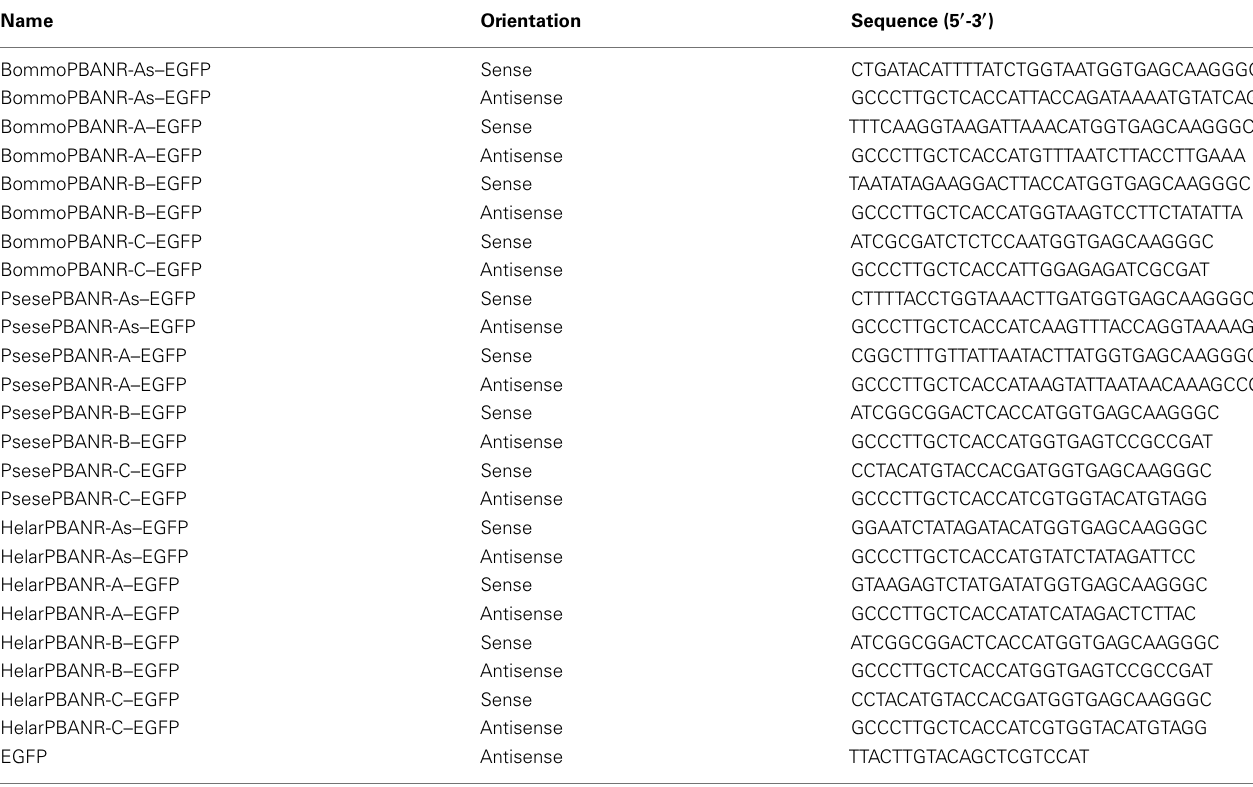
Table 2 | Primer sets used for generating fluorescent PBANR